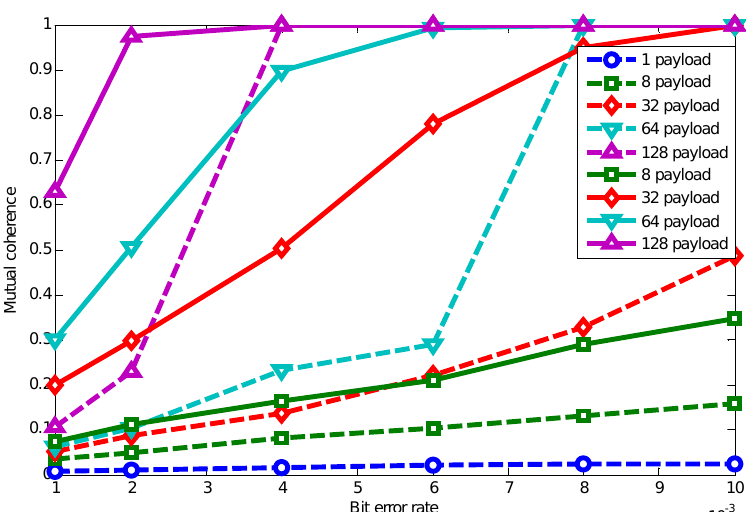
Figure 12. Packet length effect on relationship between BER and mutual coherence using RCS projection with interleaving.